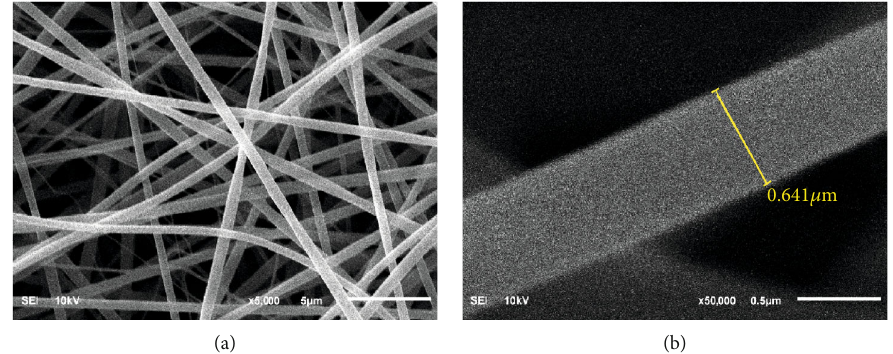
Figure 2: SEM image of the PVP8 nano fi bers at (a) 5000x (scale: 5 μ m) and (b) 50000x (scale: 0.5 μ m) for fi ber diameter calculation. Table 4: ANOVA results for a single e ff ect.